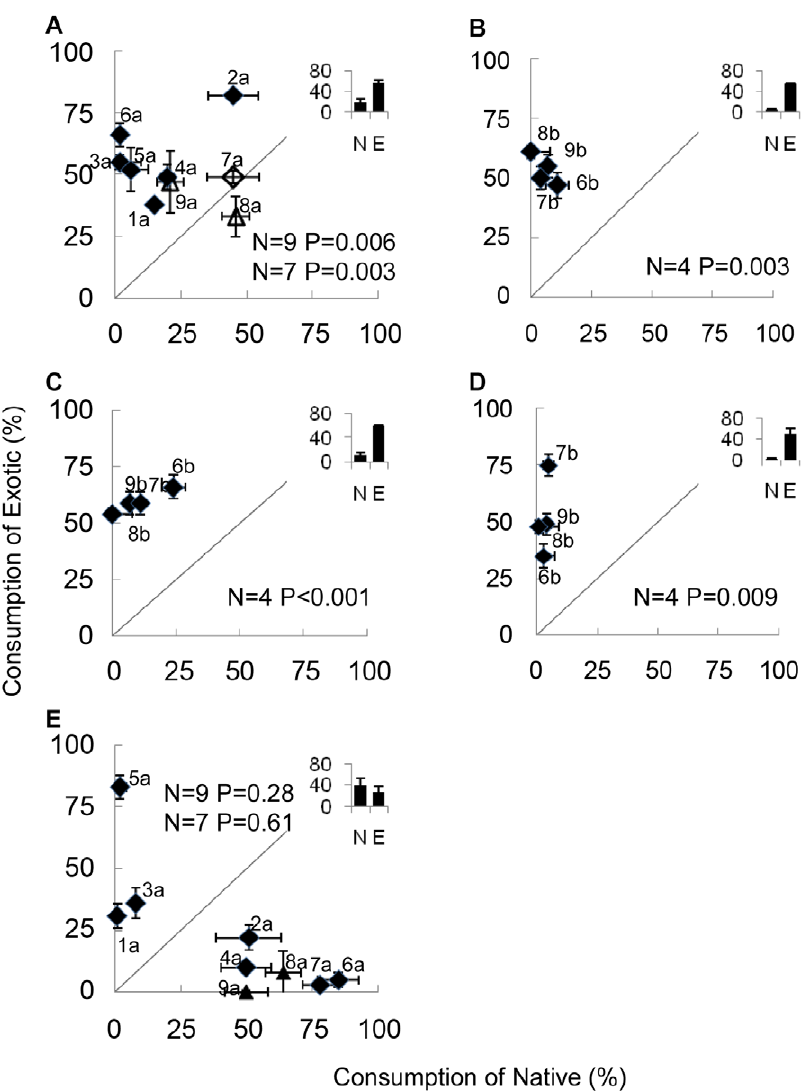
Figure 1. Consumption (mean ± 1SE) of confamilial pairs of native vs exotic macrophytes by five herbivore species: (a) P.spiculifer , (b) P.canaliculata , (c) P.insularum , (d) P.haustrum , and (e) P.paludosa . The sloping line in each figure represents the 50:50 distribution expected if there is no preference for native versus exotic plants. The filled-in symbols indicate significant preference for one plant in that pair. Inset histograms show the mean consumption across exotic and native plant pairings. P-values from two-tailed paired T-tests are for the pooled histogram data. The triangles present in a) and e) represent comparisons including Ludwigia grandiflora and Pistia stratiotes , plants whose native distribution is in question. P-values for these two graphs are provided with (N=9) and without (N=7) these two data points. The a and b’s designate comparisons from the North American and South American perspective, respectively.